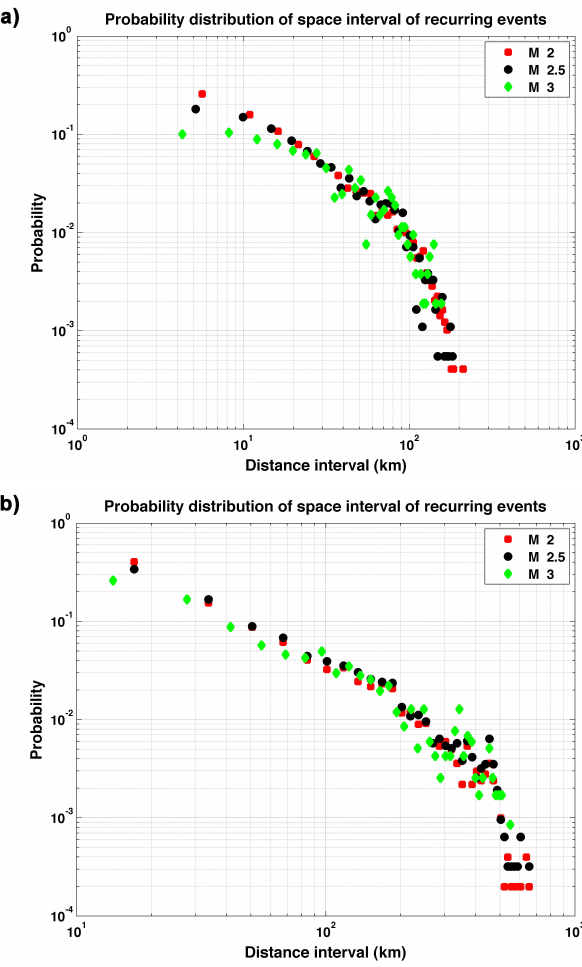
Fig. 11. Distribution of distance-intervals of recurrent events for the data for different magnitude-thresholds; (a) Region 1; (b) Region